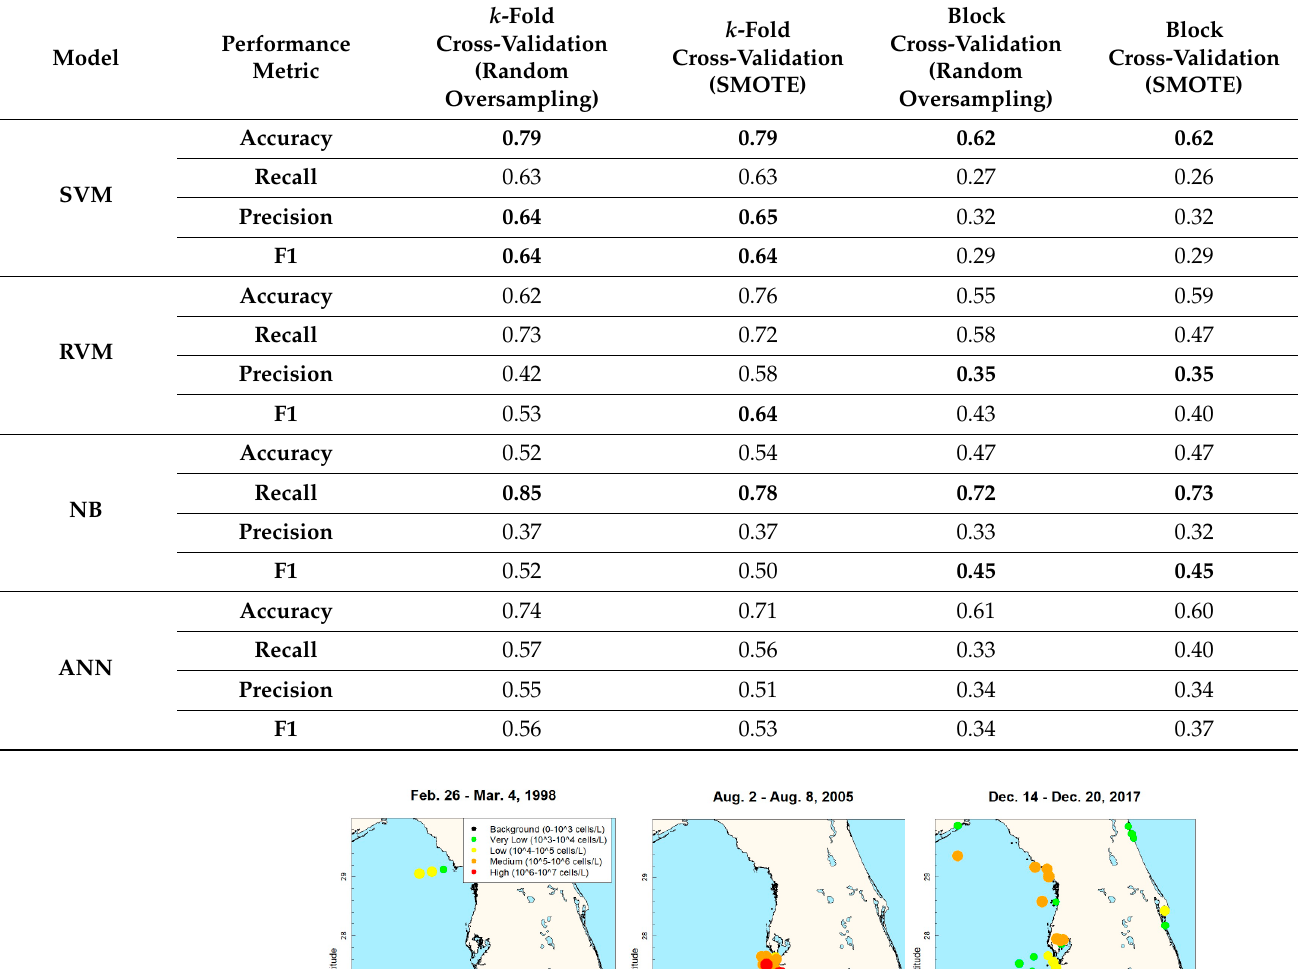
Table 1. Comparison of the four machine learning approaches applied herein (Support Vector Machine, SVM; Relevance Vector Machine, RVM; Naïve Bayes, NB; and Artificial Neural Network, ANN), as validated using k -fold cross-validation and block cross-validation. See text for equations applied. Best value for each metric in each column is in bold.